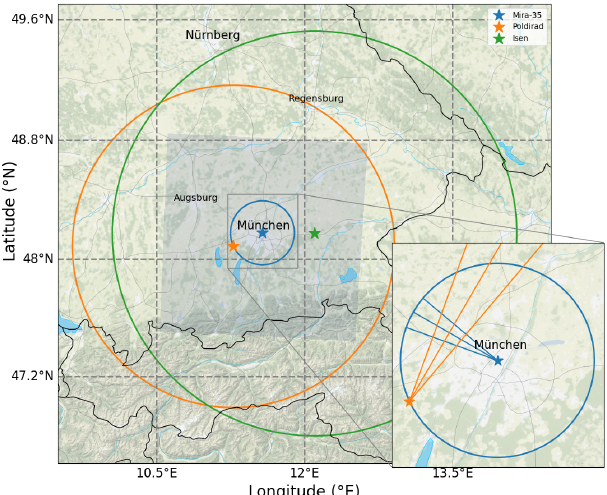
Figure 1. Radar locations and model domain. Filled blue area shows the model domain. Stars show the radar locations and the circles show the radar range around each radar. The straight blue and orange lines visualize RHI scans executed by the Mira-35 and Poldirad radar. Background map tiles by Stamen Design (http: //stamen.com, last access: 16 February 2022), distributed under the Creative Commons Attribution (CC BY 3.0) license.